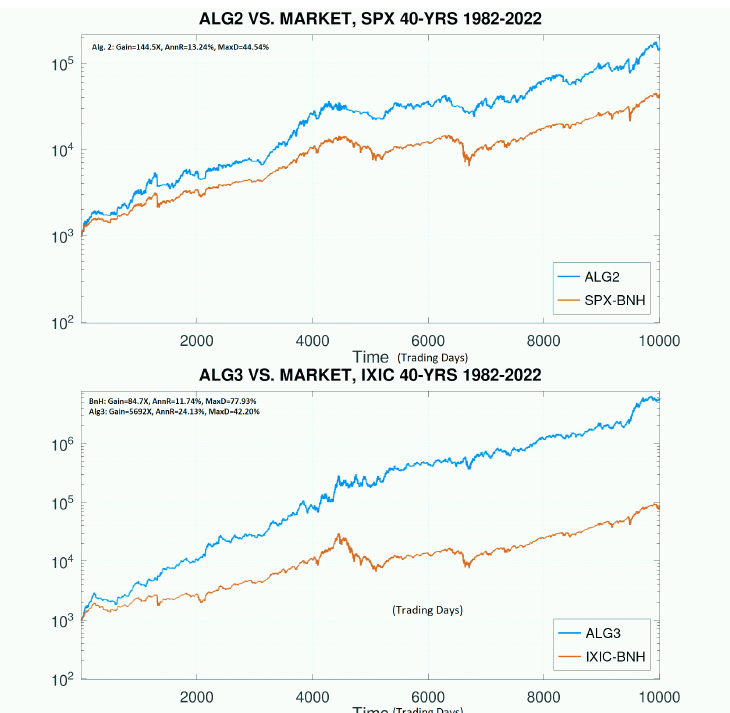
Figure 11. Performance of more sophisticated algorithms on SPX and IXIC, still based on the same set of ideas, which deliver strong performance, yet limited and improving drawdowns. Since these time periods include several major market events, including the Black Swans, these results indicate that fairly elementary algorithms can indeed deliver powerful investment results, which may be applicable to both professional and individual small